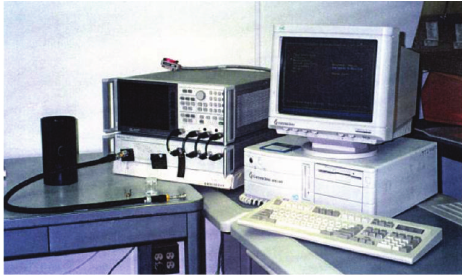
Figure 4: Hewlett packard complex dielectric network analyzer.